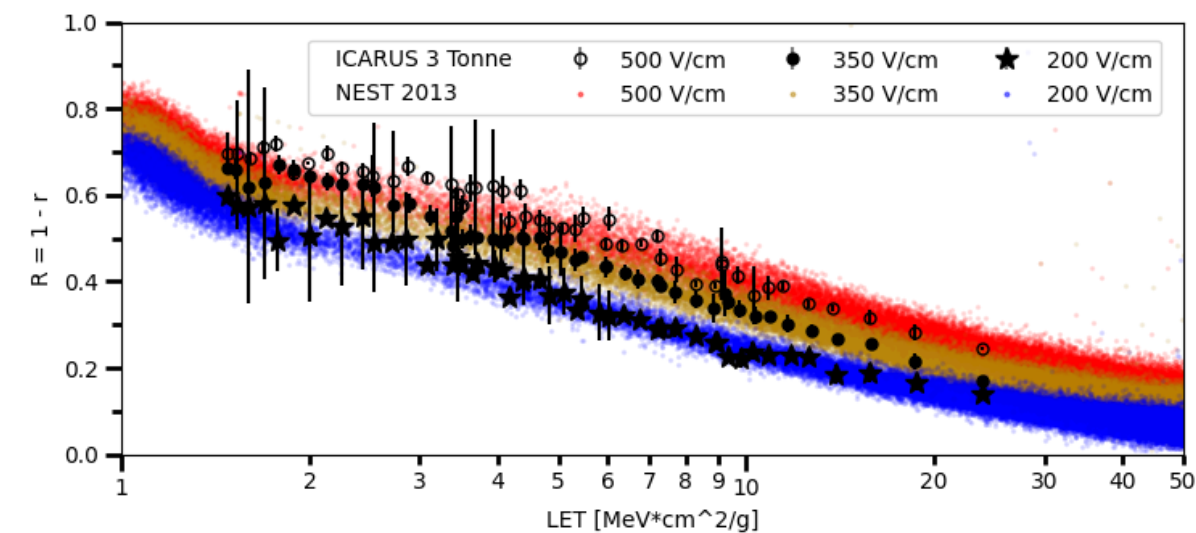
Figure 9. R vs. dE / dx in ICARUS data (stopping muons, protons) [188] at fields 500, 350, 200 V/cm. Data in black/white, as white circle, black circle, and black star, while results of a Geant4 MC making use of the NEST 2013 LAr ER model are colored red, yellow, and blue respectively, with decreasing field; protons, muons, electrons, and their respective antiparticles, while varying in R at the 5% level, are sufficiently consistent to combine. The x-axis here is linear energy transfer (LET), or, dE / dx divided by density (NEST points extracted by individual secondary track from 1 GeV total- E